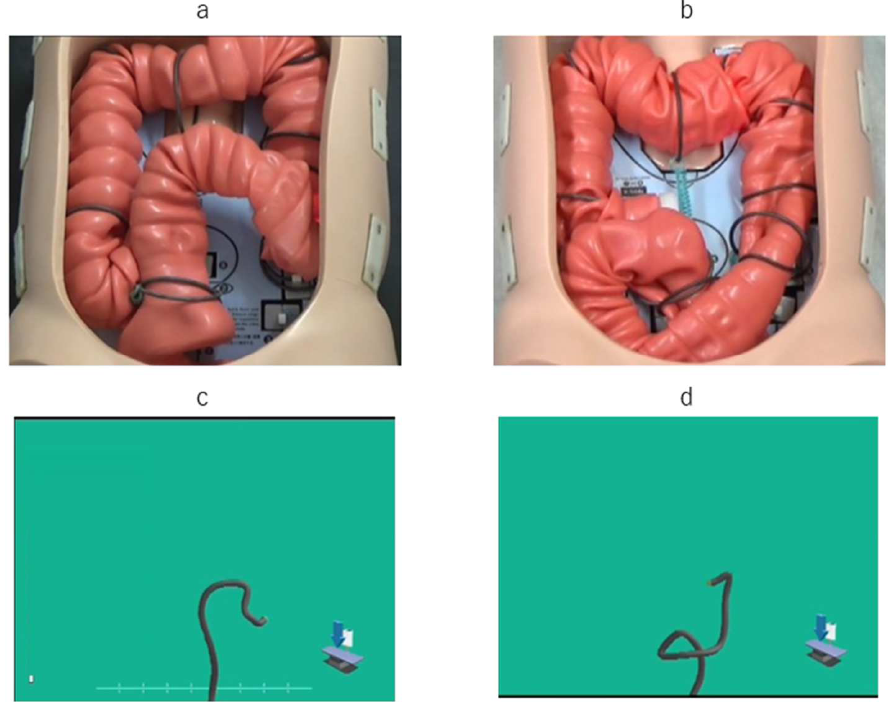
Figure 1. UPD colonoscopy as a colon model: in the N-loop formation colon model ( a ) and the UPD graphic image ( b ); in the α loop-forming colon model ( c ) and the UPD graphic image ( d ).